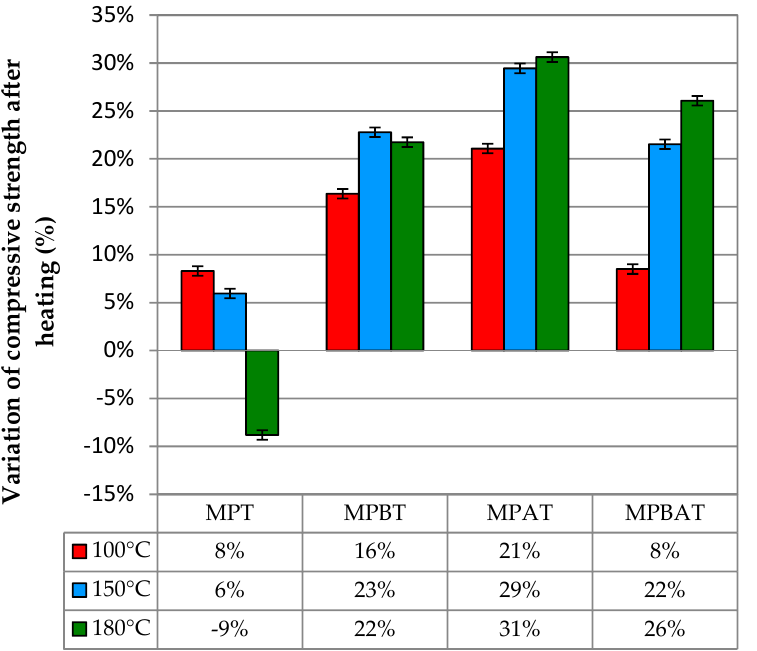
Figure 2. Failure of samples under compression test (all tests were conducted in triplicate). The negative percentage for variation of compressive strength of MPT specimens is in agreement with previous studies that indicated the adverse effect of elevated temperature on the hardened specimens. The increase in the variation of compressive strength in MPBT, MPAT, and MPBAT supports the finding of this research that the addition of BF and SA enhances the compressive strength of PC. The highest positive influence by raised temperature is corresponding to the mixture including SA alone that with an increase in the temperature from room temperature to 100 ◦ C then 150 ◦ C and finally to 180 ◦ C, growth in the compressive strength became 21.08%, 29.45%, and 30.61%, respectively. A lower increase of the compressive strength of the BF-reinforced PC is due to the entrapped voids because of fiber addition. The obtained results about enhanced temperature resistance of SA-based mortar specimens also conform to the finding of DeBrouse [23].